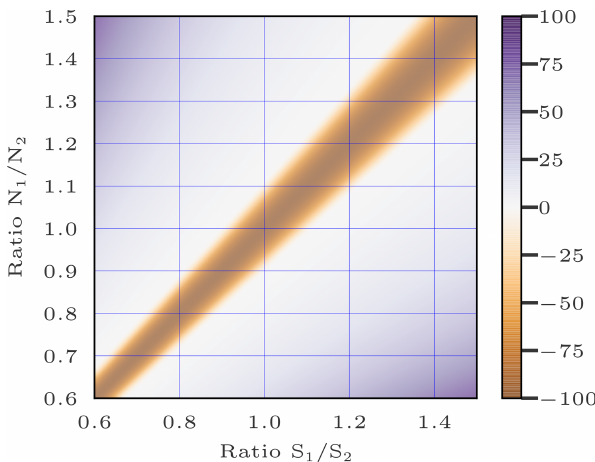
Figure B1. AIC(0) − AIC (d) with negative values multiplied by 100 to be more visible. Negative values indicate the cases where the model (0) with one variable is preferable. Positives values indi- cate the cases where the model (d) with two variables is preferable. On the x axis is the ratio between the likelihoods S 1 and S 2 linked to variables 1 and 2, respectively, of the model (d) . On the y axis is the ratio between the numbers of observations N 1 and N 2 linked to variables 1 and 2, respectively, of the model (d)